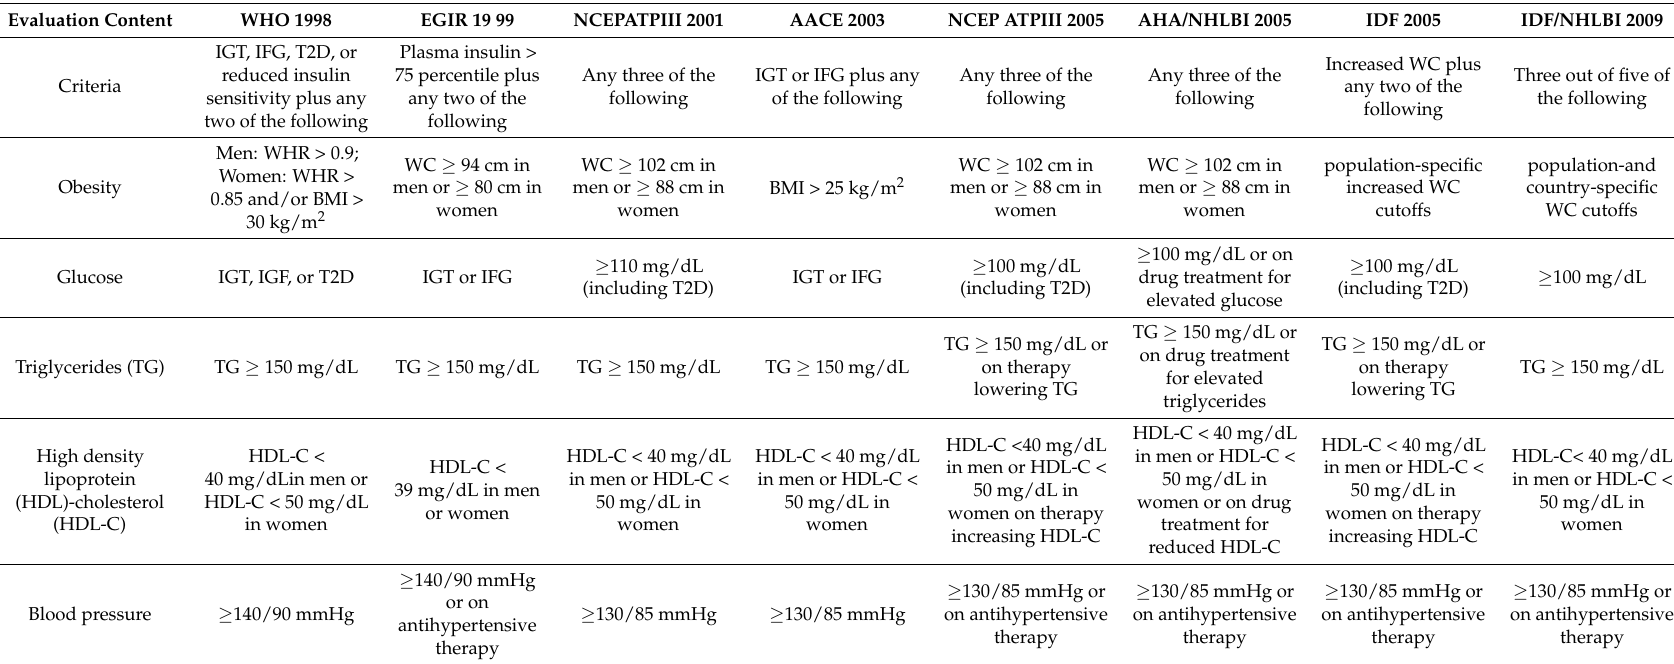
Table 1. Development of clinical criteria of metabolic syndrome by different health